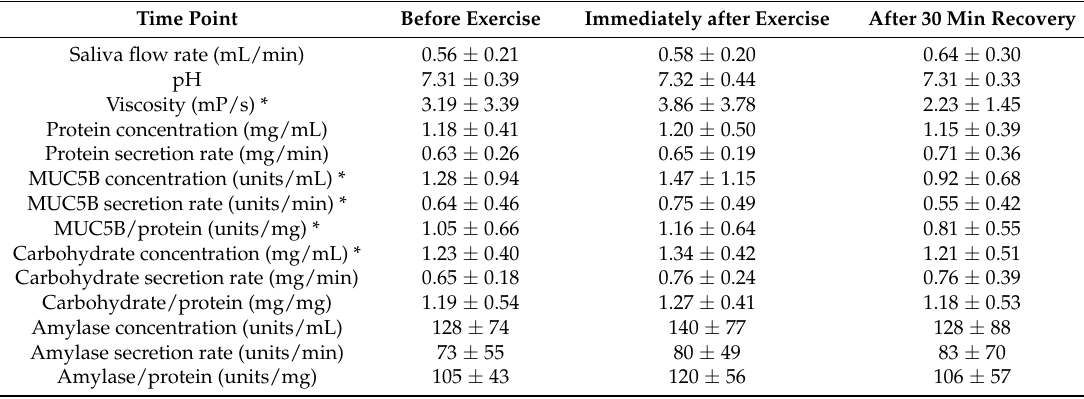
Table 1. Effect of exercise on the saliva flow rate, pH, viscosity and composition of saliva. Values are mean ± standard